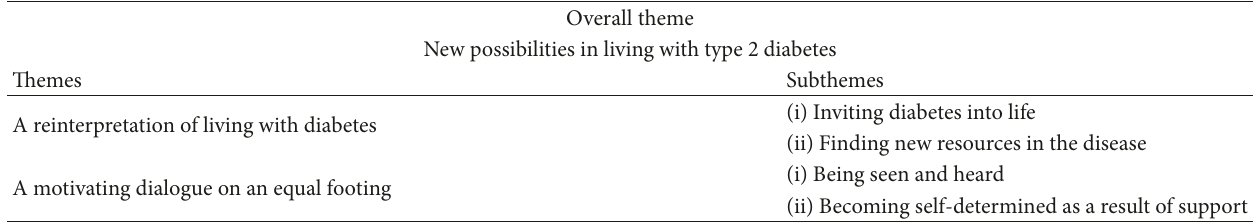
Table 1: Overview of overall theme, themes and subthemes in the qualitative content